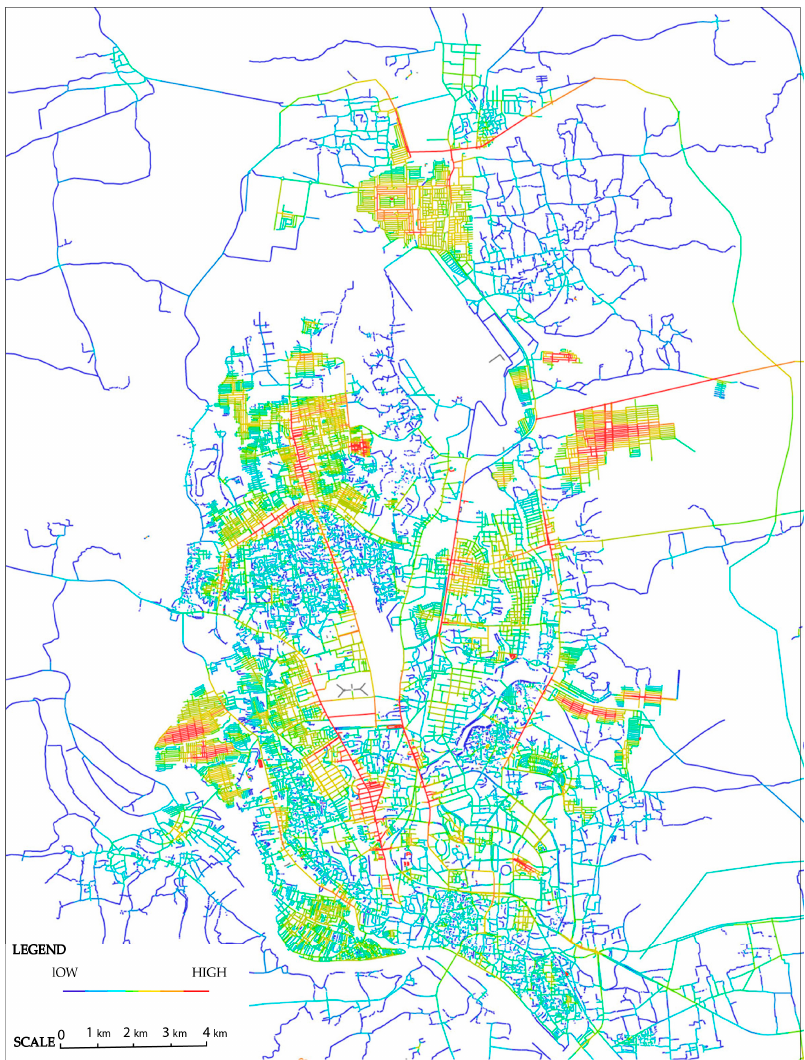
Figure 4. Results of Space Syntax analysis. Blue to red represents lower to higher street integration.